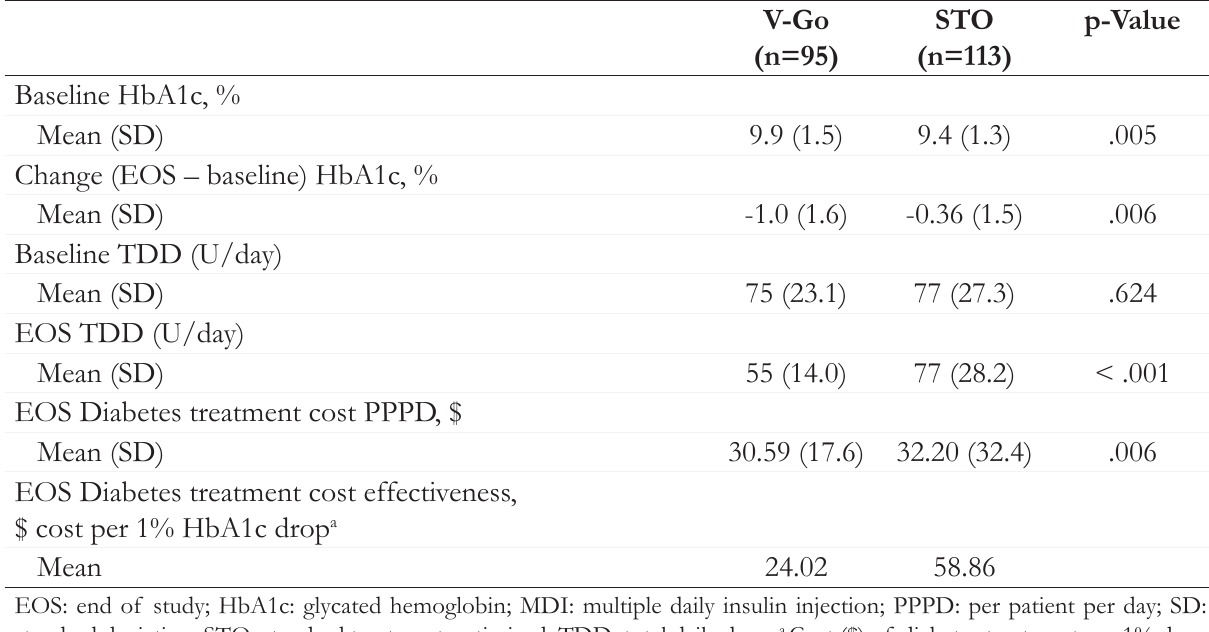
Table 4. Glycemic Control, Insulin Dose, and Cost in the MDI